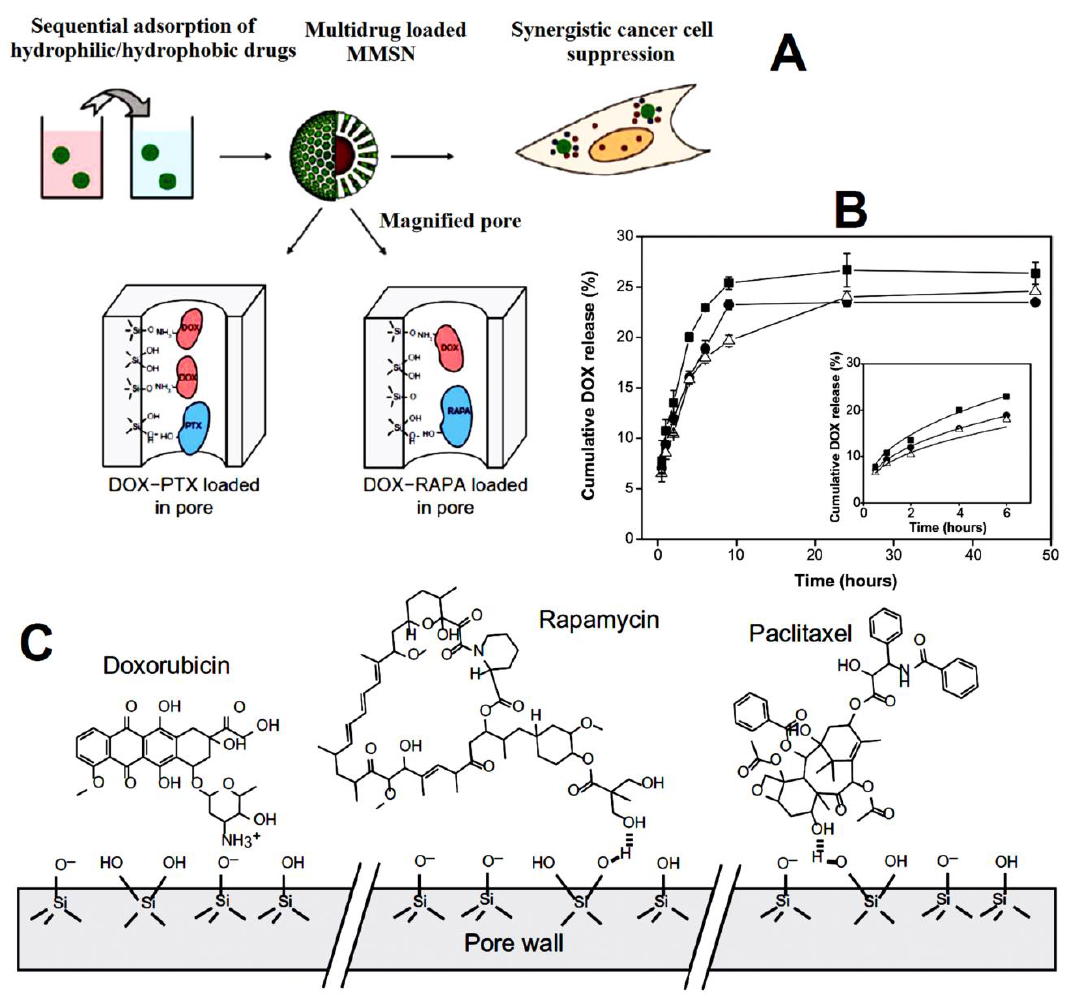
Figure 1. Release and interaction data of MMSN in co-delivery of DOX, RAPA, and PTX. ( A ) Synthesis design of MMSNs and loading interaction of drugs inside the pores. ( B ) DOX release rate individually ( ◼ ), from DOX-PTX co-loaded NPs (●), from DOX-RAPA co-loaded NPs (∆). ( C ) The interactions of the mesoporous silica pore walls with drug molecules. Reproduced from Liu et al. [3],